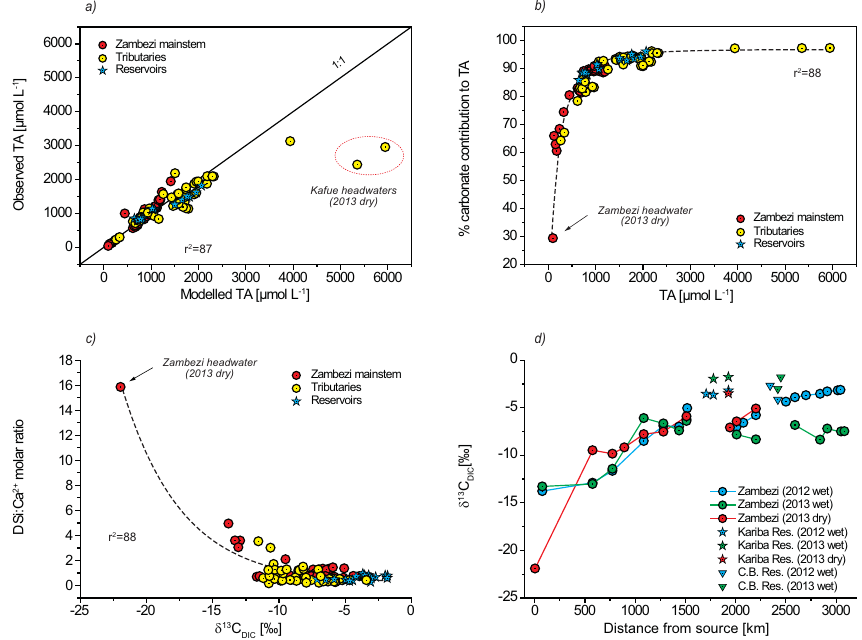
Figure 7. Relationships between (a) modeled and observed total alkalinity (TA), (b) the estimated contribution of TA derived from carbonate weathering to observed TA (see text for details), and (c) isotopic signature of DIC ( δ 13 C DIC ) to DSi:Ca 2 + molar ratio. Panel (d) shows the spatiotemporal variability of δ 13 C DIC along the Zambezi